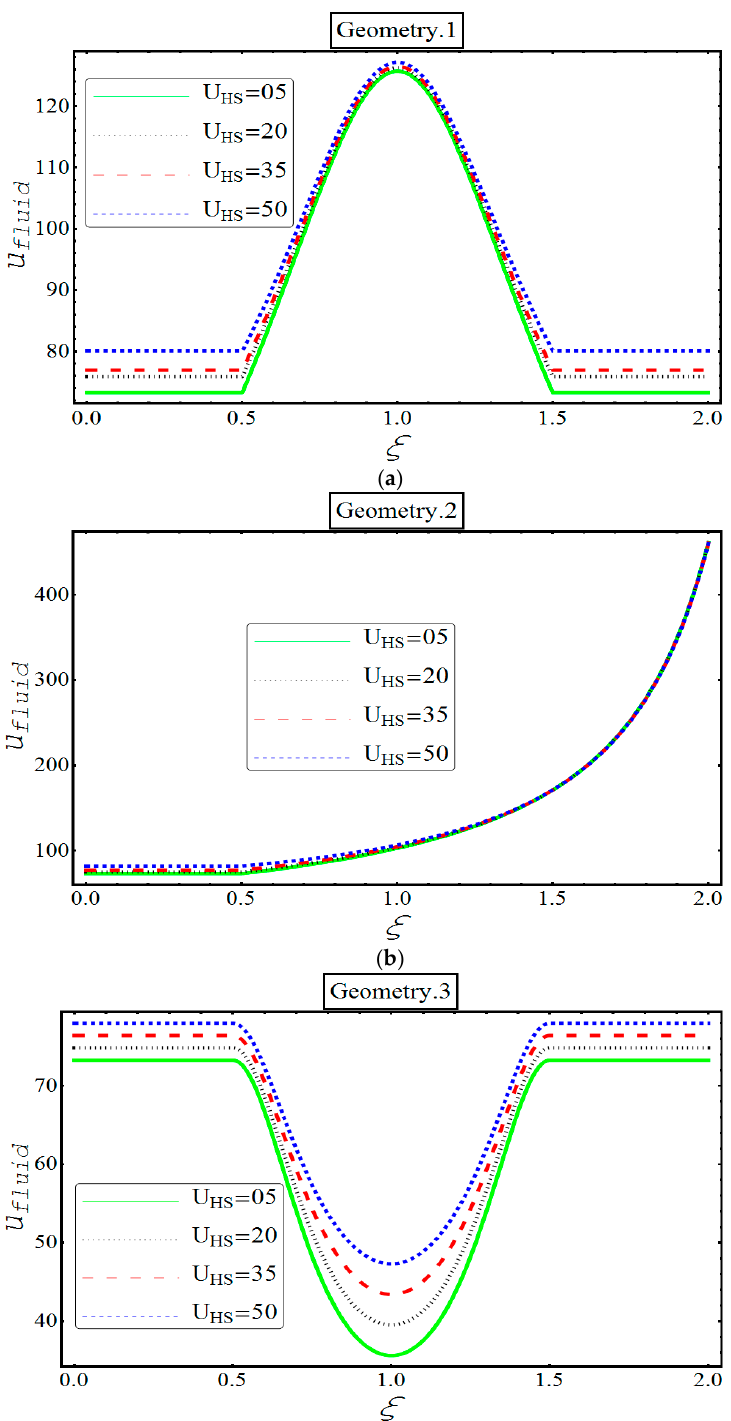
Figure 8. Variation of the velocity (cid:1873) (cid:3033) for various Helmholtz–Smoluchowski parameters.